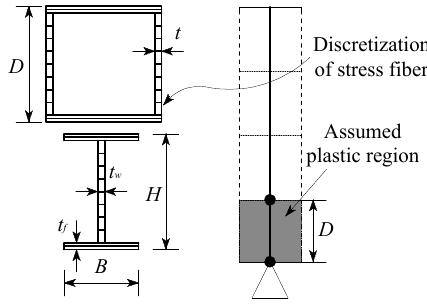
Figure 1. Fiber element discretization and plastic region.